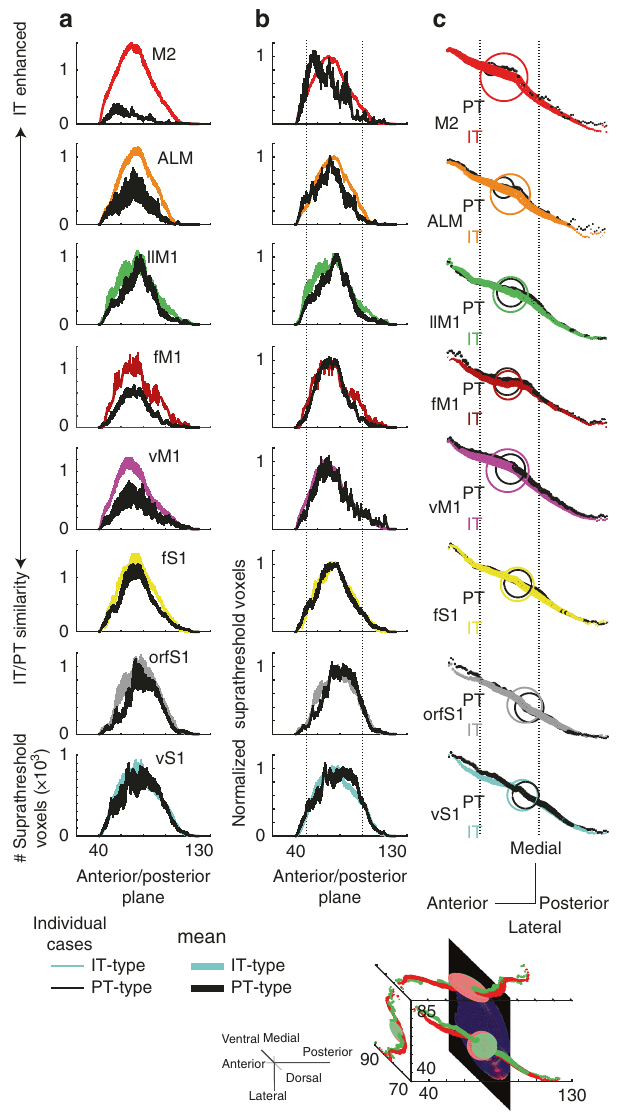
Fig. 5 Anterior/posterior localization of IT-type and PT-type corticostriatal projections. a Anterior/posterior location of suprathreshold voxels in ipsilateral striatum was quanti fi ed for IT-type and PT-type injection cases. Mean ± SEM plotted. IT-type projections are highlighted in color (for example, vS1 is teal). Corresponding PT-type projections from the same cluster are plotted in black on the same axes. Number of suprathreshold voxels is similar for vS1, orfS1, and fS1 injections. Suprathreshold voxels for IT-type projections from frontal areas exceed those of PT-type projections. b Peak normalized distribution (Mean ± SEM) of IT-type and PT-type projections are shown. These peak at similar points on the anterior/ posterior axis. c To assess differences in targeting of IT-type and PT-type projections within the same injection site cluster, the center of mass of corticostriatal fl uorescence of the voxels for the mean normalized injection pattern was calculated for each injection site cluster. Overall center of mass is shown as a large circle (red (vS1 IT-type) and green (vS1 PT-type) circles, example at bottom). Corticostriatal fl uorescence center of mass of each plane is plotted as a circle, and projections along the x / y / z -axes are shown. Size of the circle is proportional to the summed normalized voxel intensity for a given plane. Anterior/posterior projections for each injection cluster are shown above. Color code corresponds to the injection site cluster (teal for vS1), with IT-type projections shown in color and corresponding PT-type projections shown in black. Dotted line is shown for anterior/posterior alignment across injection clusters. Corticostriatal fl uorescence center of mass of vS1, orfS1, and fS1 (teal, gray, and gold, respectively) are posterior within the striatum, while frontal areas ALM and M2 (orange and red) are anterior. Overall center of mass of corticostriatal fl uorescence overlaps for IT- and PT-type cases, resulting in overlap of these markers. Scale, 1 mm (bottom